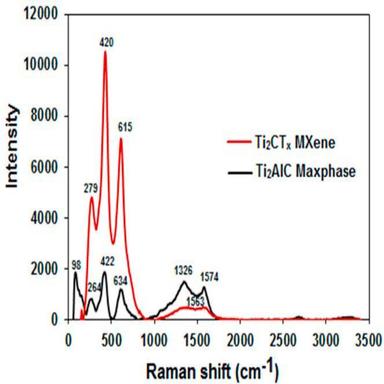
Raman spectra of Ti2AlC MAX phase and Ti2CTx MXene